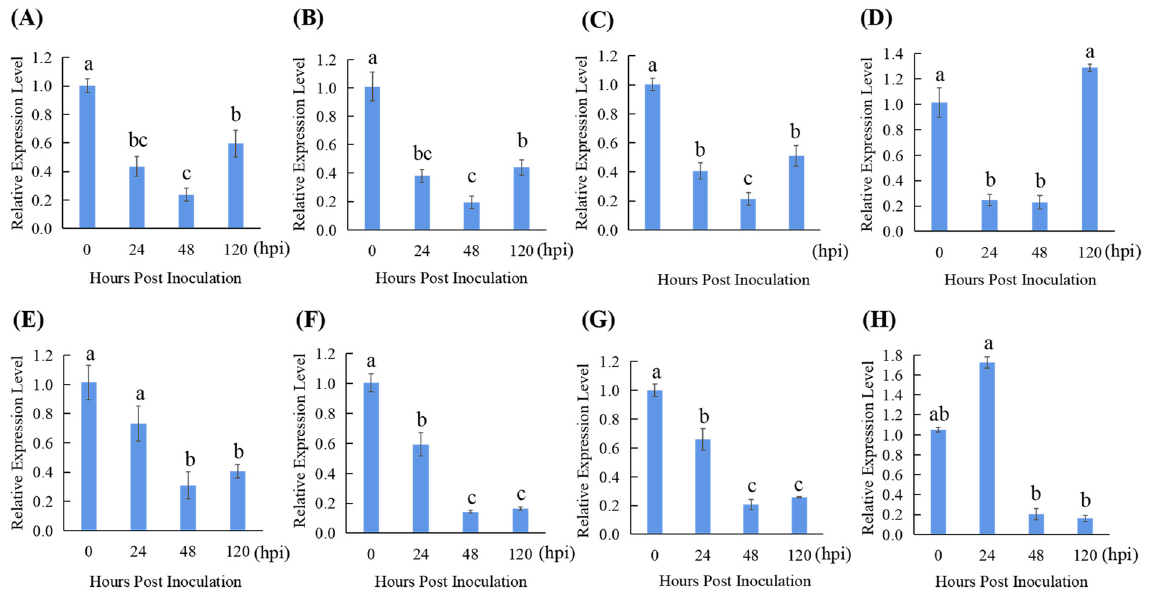
Figure 4. Relative expression normalization of SlMLO1 genes in ‘MM’ and ‘62579 ′ . ( A ) Using Act as reference gene in ‘MM’. ( B ) Using GAPDH as reference gene in ‘MM’. ( C ) Using the reference gene combination of Act and GAPDH in ‘MM’. ( D ) Using UK as reference gene in ‘MM’. ( E ) Using Act as reference gene in ‘62579 ′ . ( F ) Using EF1 α as reference gene in ‘62579 ′ . ( G ) Using the reference gene combination of Act and EF1 α in ‘62579 ′ . ( H ) Using TIP41 as reference gene in ‘62579 ′ .